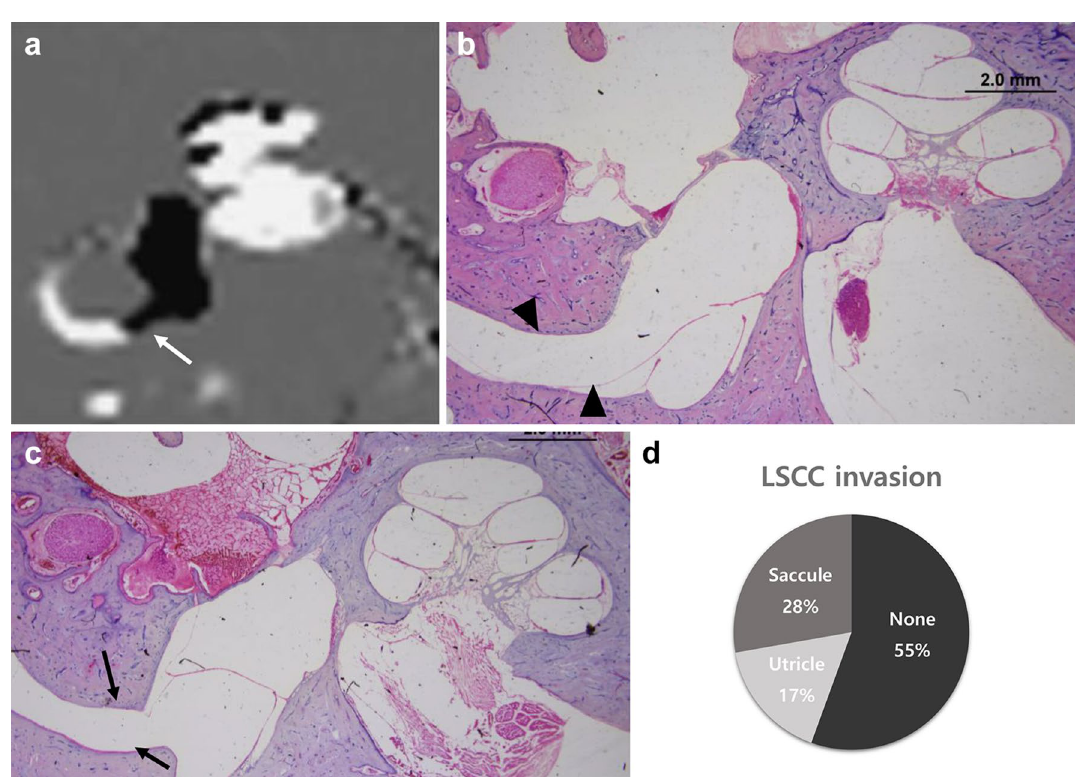
Figure 5. Vestibule endolymphatic hydrops (EH) observed on MRI and histopathology images. On inner- ear MRI, the hydrops of the vestibule extended toward the non-ampullary region (white arrow) of the lateral semicircular canal (LSCC) ( a ). In the histopathological section, the saccular hydrops (black arrowhead) progressed and extended to the LSCC, ( b ) and the utricle also invaded the LSCC (black arrow) ( c ). The rate of extension of vestibular hydrops to the LSCC in histopathological images of MD patients ( d , 72 ears). *( a ) image was generated by OsiriX MD image software(version 7.5.1 64-bit, https:// www. osirix- viewer.